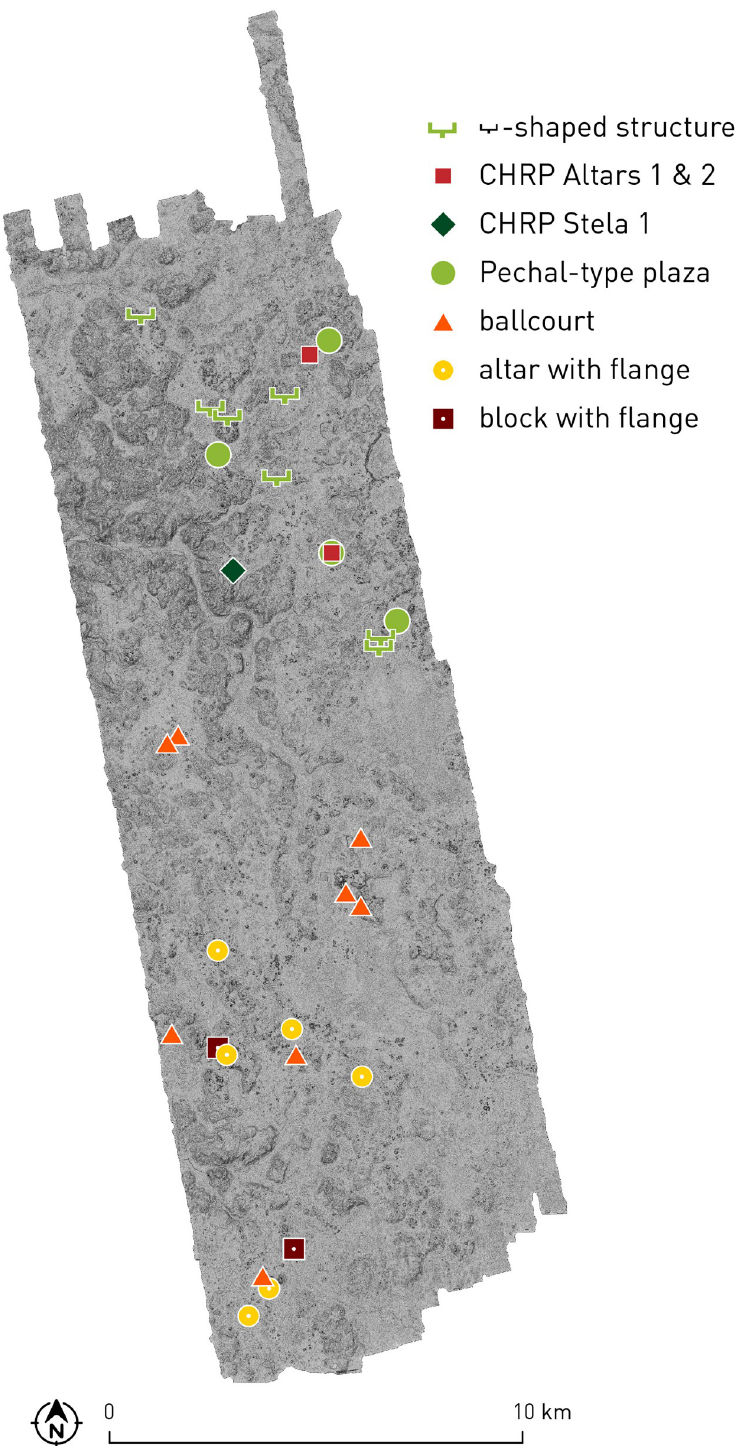
Fig 18. Distribution of certain types of archaeological features, suggesting a political division between Chactu´n and Pechal.